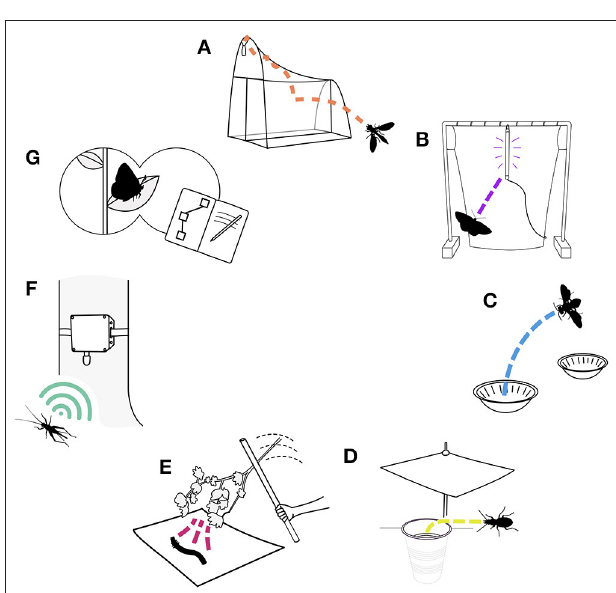
FIGURE 2 | A visual overview of the seven insect benchmarking methods summarized here: (A) malaise trapping, (B) light trapping, (C) pan trapping, (D) pitfall trapping, (E) beating sheet, (F) acoustic monitoring, and (G) active visual